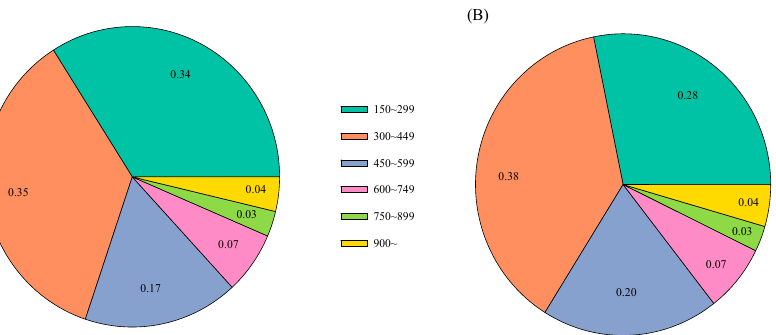
Figure 2. The contig length distribution based on the searched 159,372 SNP-Associated-blasted contigs in the de novo assembly for reliable SNP prediction ( A ), the number of the 60,038 annotated SNP- Associated-blasted contigs with blasted hits ( B ).